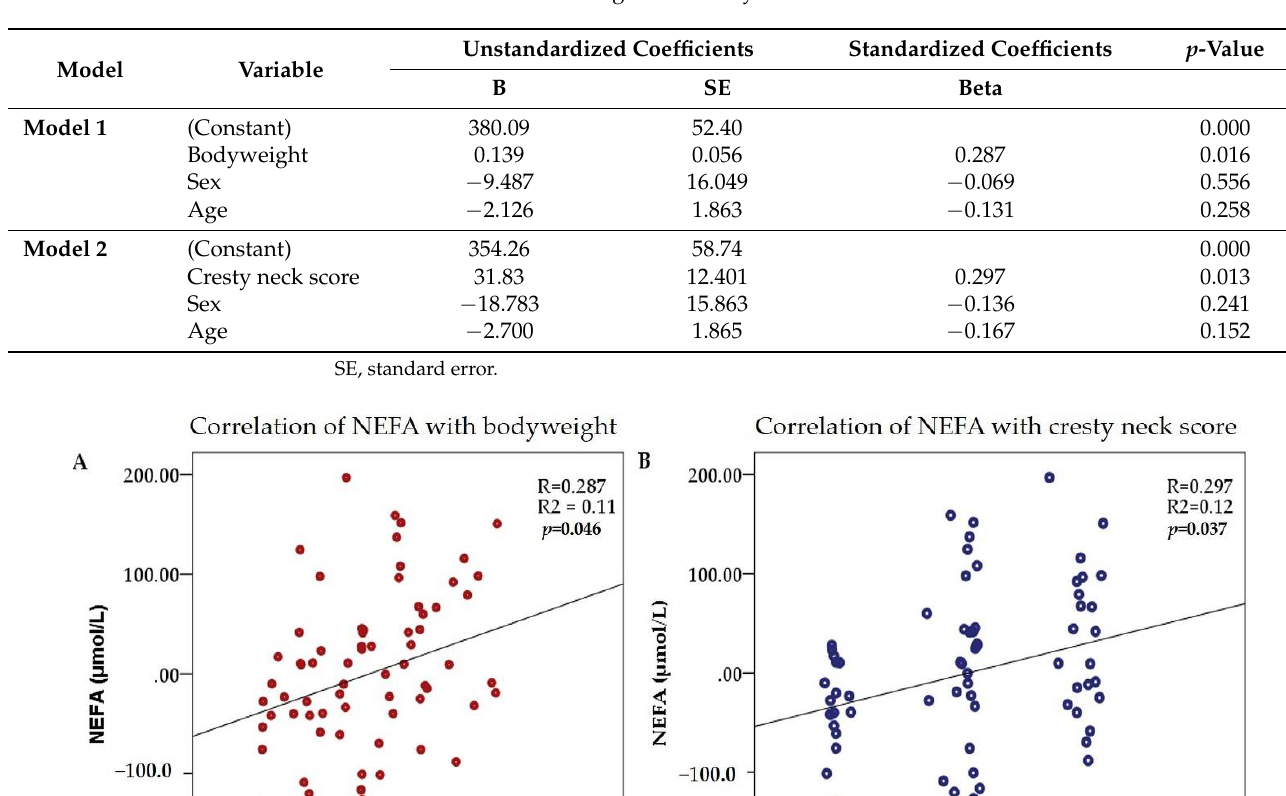
Table 4. Univariate linear regression analysis.